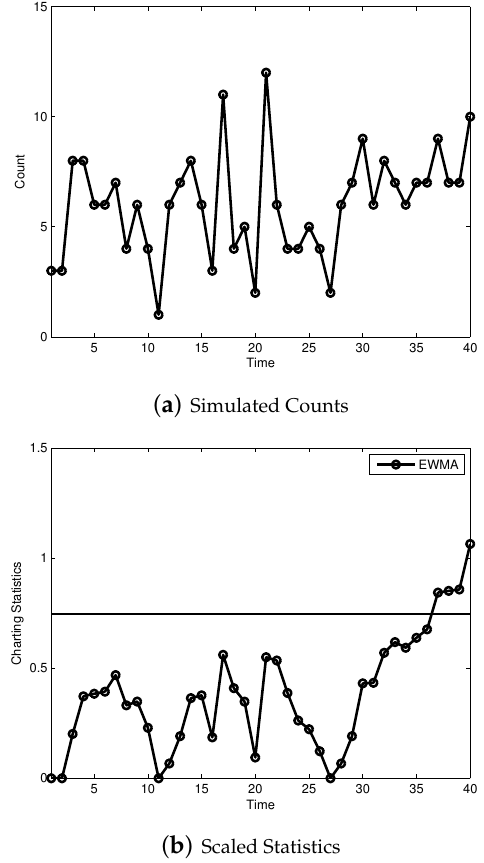
Figure 1. Simulated count data and the charting